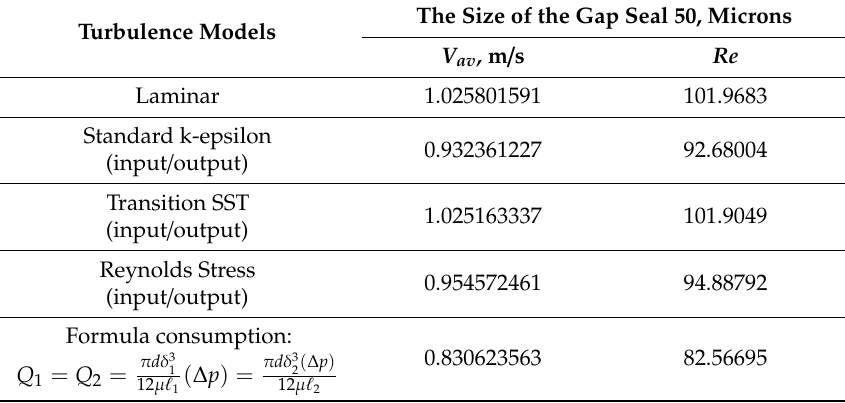
Table 6. Values of average velocities and Reynolds numbers during fluid flow in a step-type gap seals in the opposite direction determined by different flow models.